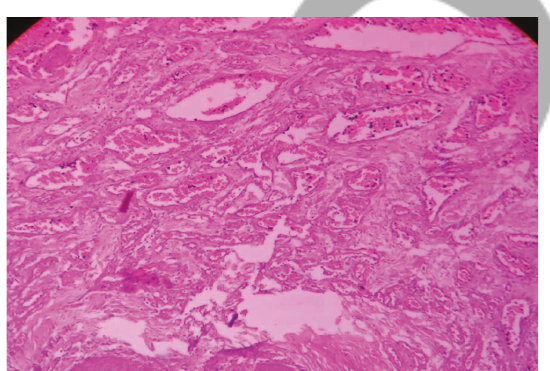
Figure 2: H and E stain section at 10x magnification showing numerous blood-filled capillaries in connective tissue stroma.